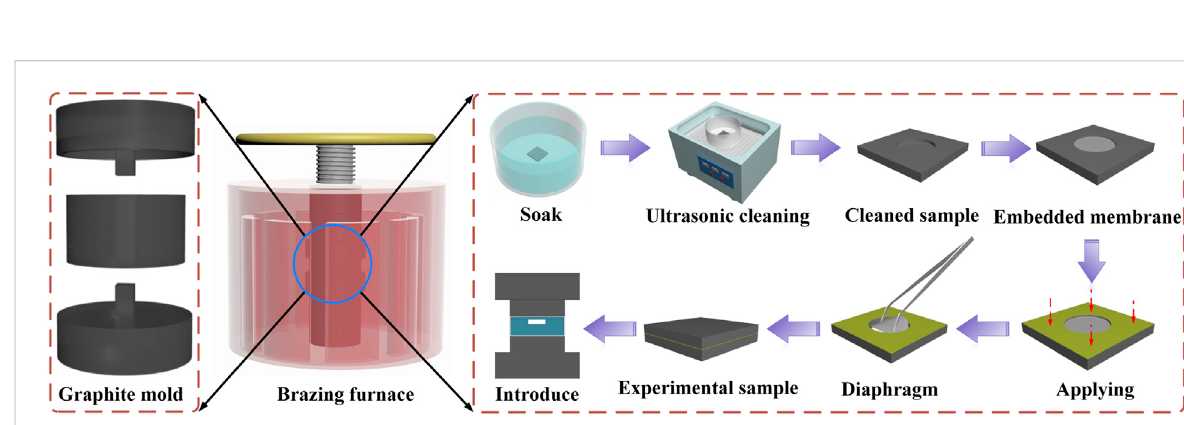
FIGURE 3 Schematic diagram of the brazing furnace and sample processing process